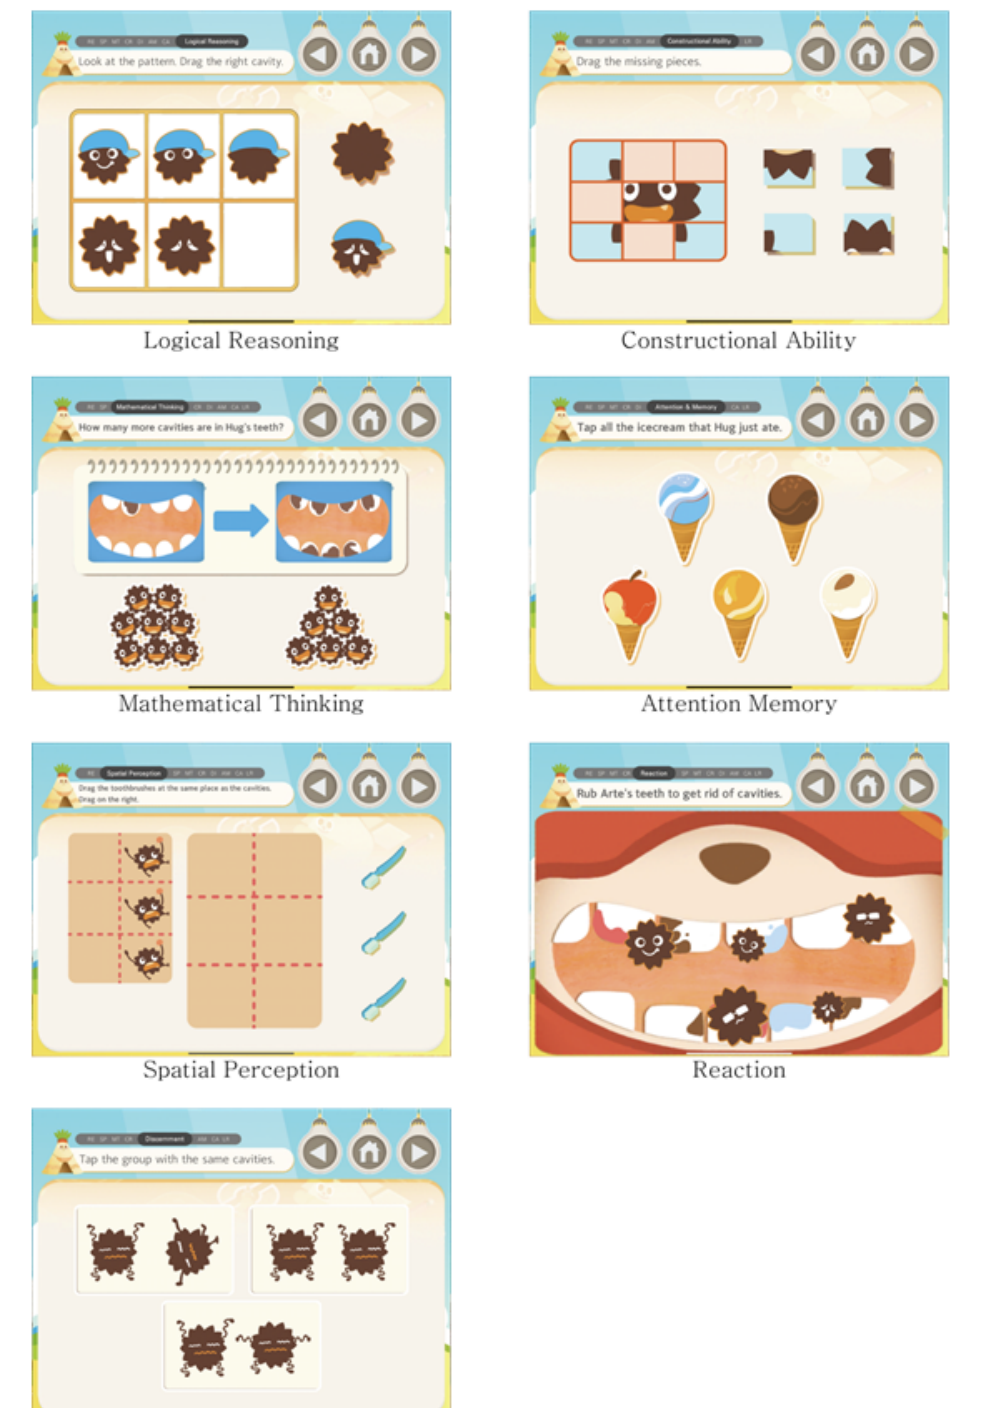
Figure 2. Screenshots of the serious game by game